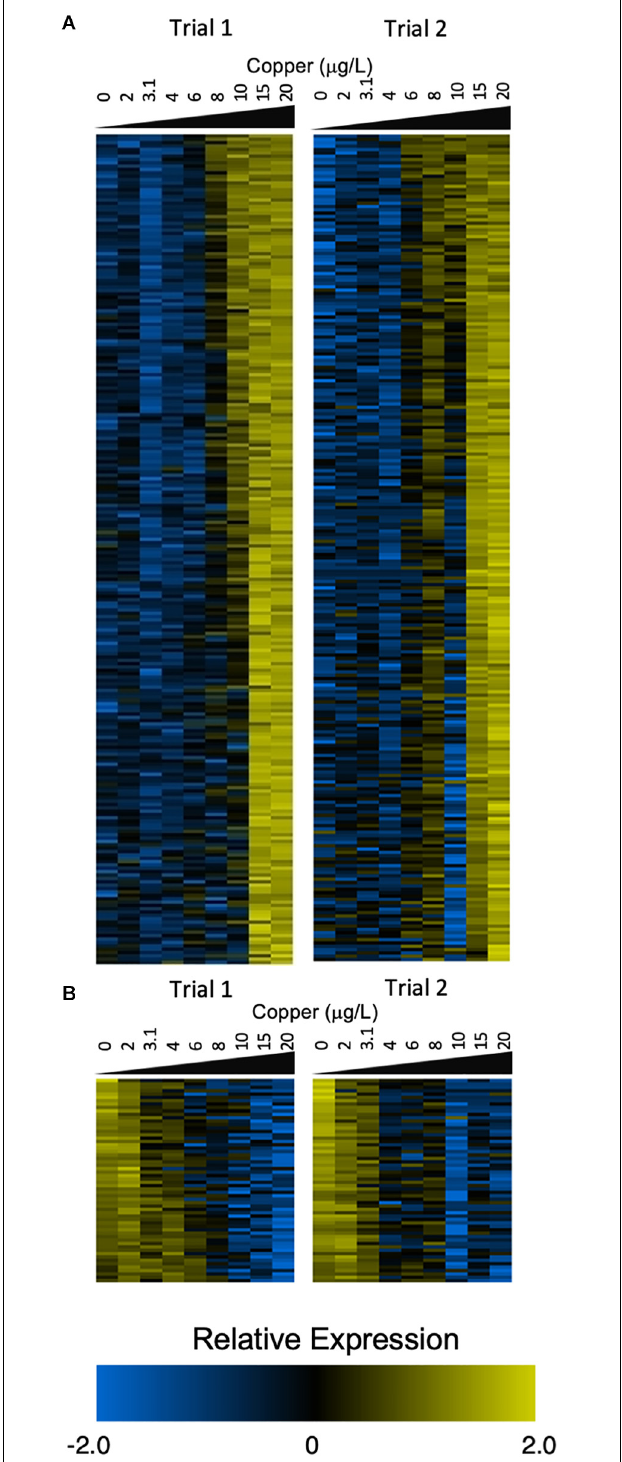
FIGURE 2 | Heatmaps depict expression of sigmoidal genes that were upregulated (A) and downregulated (B) in both trials 1 and 2 (left and right panels). Count values are control-normalized and log2 transformed. Genes were ranked by LOTEC value to create the order shown in the heat maps (A,B)